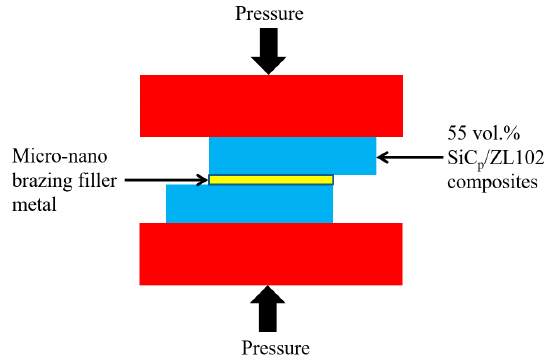
Figure 4. Schematic diagram of the brazing joint.